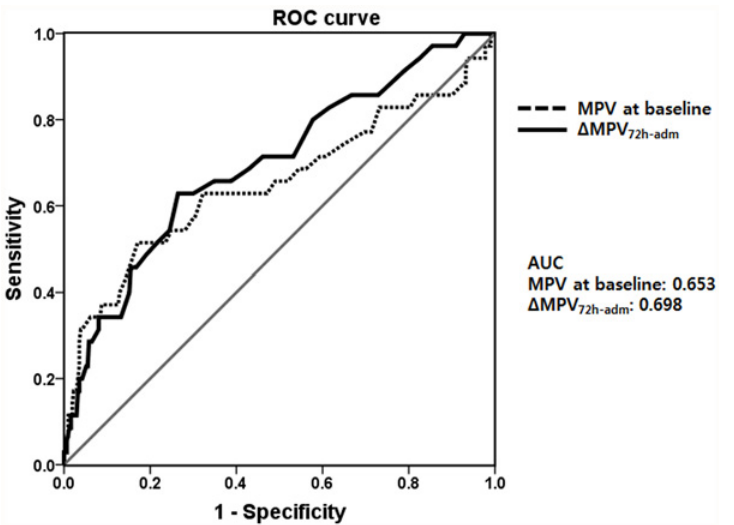
Fig 3. Receiver operating characteristic (ROC) curves of baseline MPV and Δ MPV 72h-adm for 28-day all-cause mortality. Area under the curve (AUC) of baseline MPV and Δ MPV 72h-adm were 0.653 and 0.698,